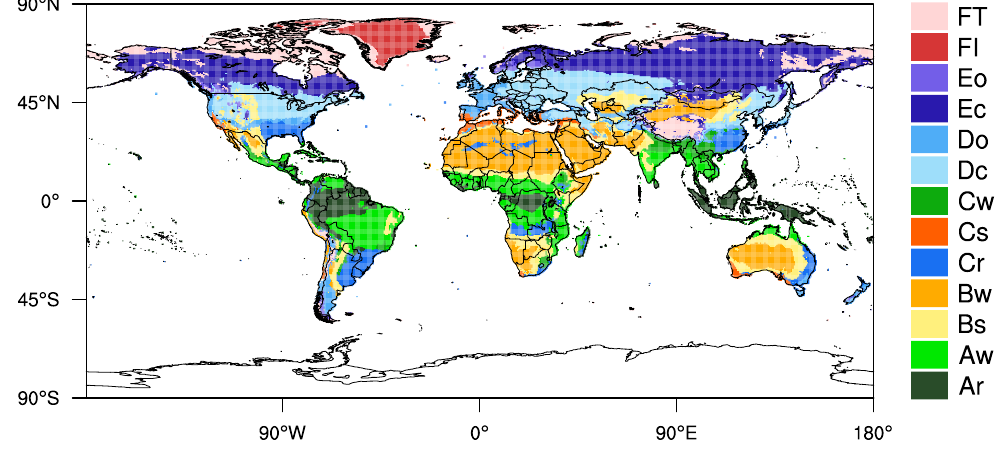
Figure 1. K ¨ oppen-Trewartha (K-T) climate types. The derived K ¨ oppen-Trewartha (K-T) climate classification based on the 30-year mean of the CRU dataset: FT (tundra/highland), FI (ice cap), Eo (sub-arctic oceanic), Ec (sub-arctic continental), Do (temperate oceanic), Dc (temperate continental), Cw (subtropical summer-wet), Cs (subtropical summer-dry), Cr (subtropical humid), BW (dry arid), BS (dry semi-arid), Aw (tropical wet-dry), Ar (tropical humid) see also Table